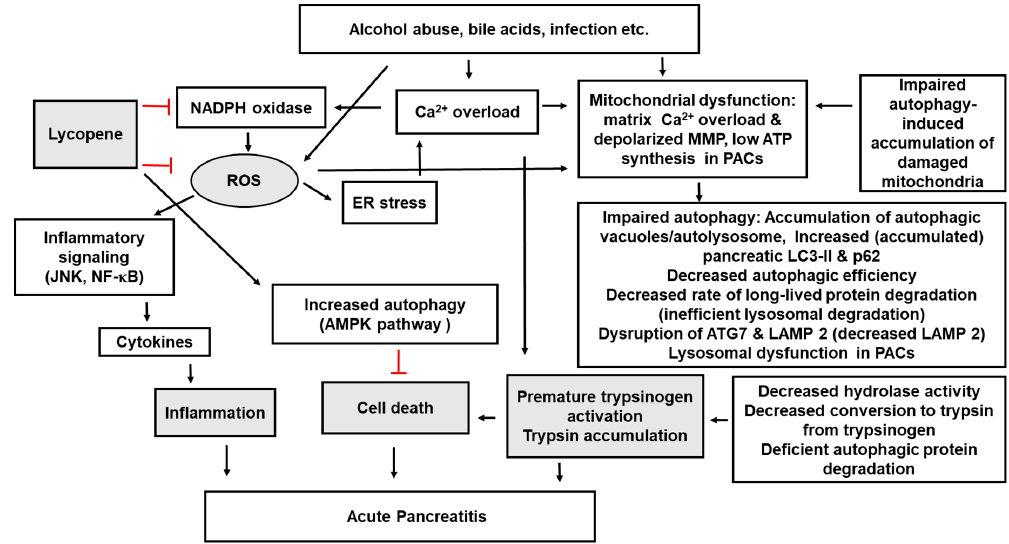
Figure 1. Possible mechanisms by which lycopene attenuates the pathology of acute pancreatitis via its effect on autophagy. Various stimuli (alcohol abuse, bile acids due to duct obstruction by gallstones, infection) lead to increased reactive oxygen species (ROS), intracellular and mitochondrial Ca 2+ overload, and dysfunction of mitochondria in pancreatic acinar cells (PACs). Activated Ca 2+ signaling also stimulates ROS production in PACs.